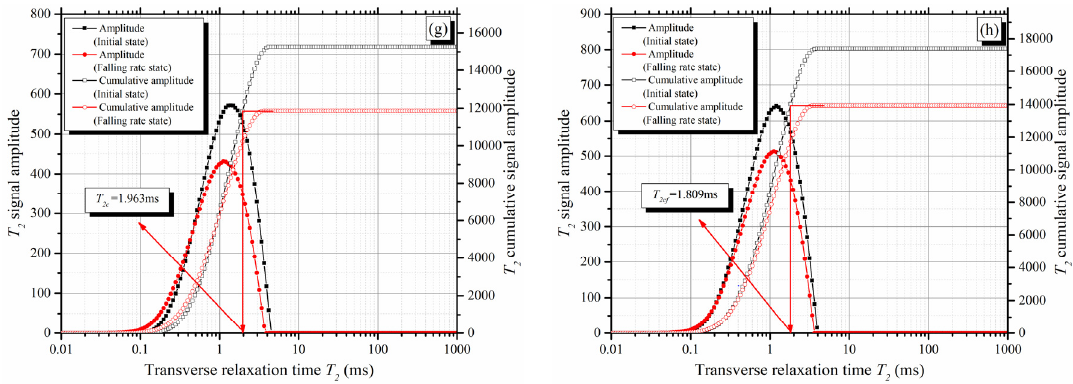
Figure 10. T 2 cut-offs ( T 2 c ) of the eight mixtures: ( a ) K40; ( b ) K60; ( c ) K80; ( d ) K100; ( e ) M40; ( f ) M60; ( g ) M80; ( h ) M100. The black curve with a solid square and red curve with solid circle indicate T 2 spectra of the saturated mixture before evaporation and the mixture at the beginning of the falling rate stage, respectively. The curves with an open square and open circle indicate the cumulative signal amplitude of T 2 spectra with the same color. The intersection of the black curve with the open square and the red curve with the open circle was enlarged and placed in the upper left corner of ( a – d ).